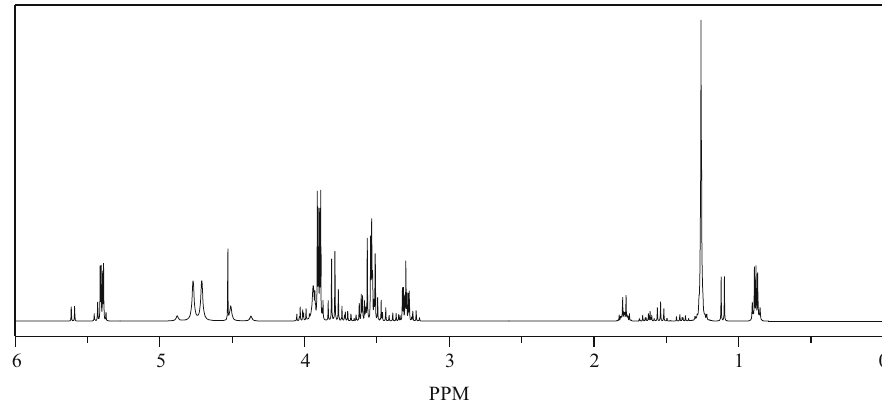
Figure 3: H - NMR spectrum of RH - β -